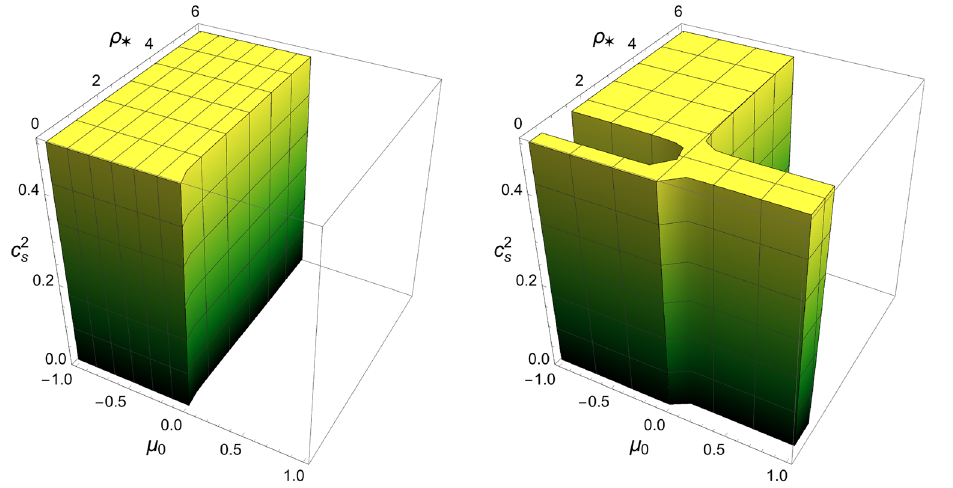
Fig. 1 Regions of existence H cp > 0 (Eq. (31)) within (μ 0 ,ρ ∗ , c 2 s ) parameter space, for flat, open (left panel) and closed (right panel) Snyder deformed quantum cosmology with equation-of-state parameter close to − 1 (here ω = − 0 . 98) and any arbitrary value (cid:3) ∗ m ∈ ( 0 . 2 , 0 . 5